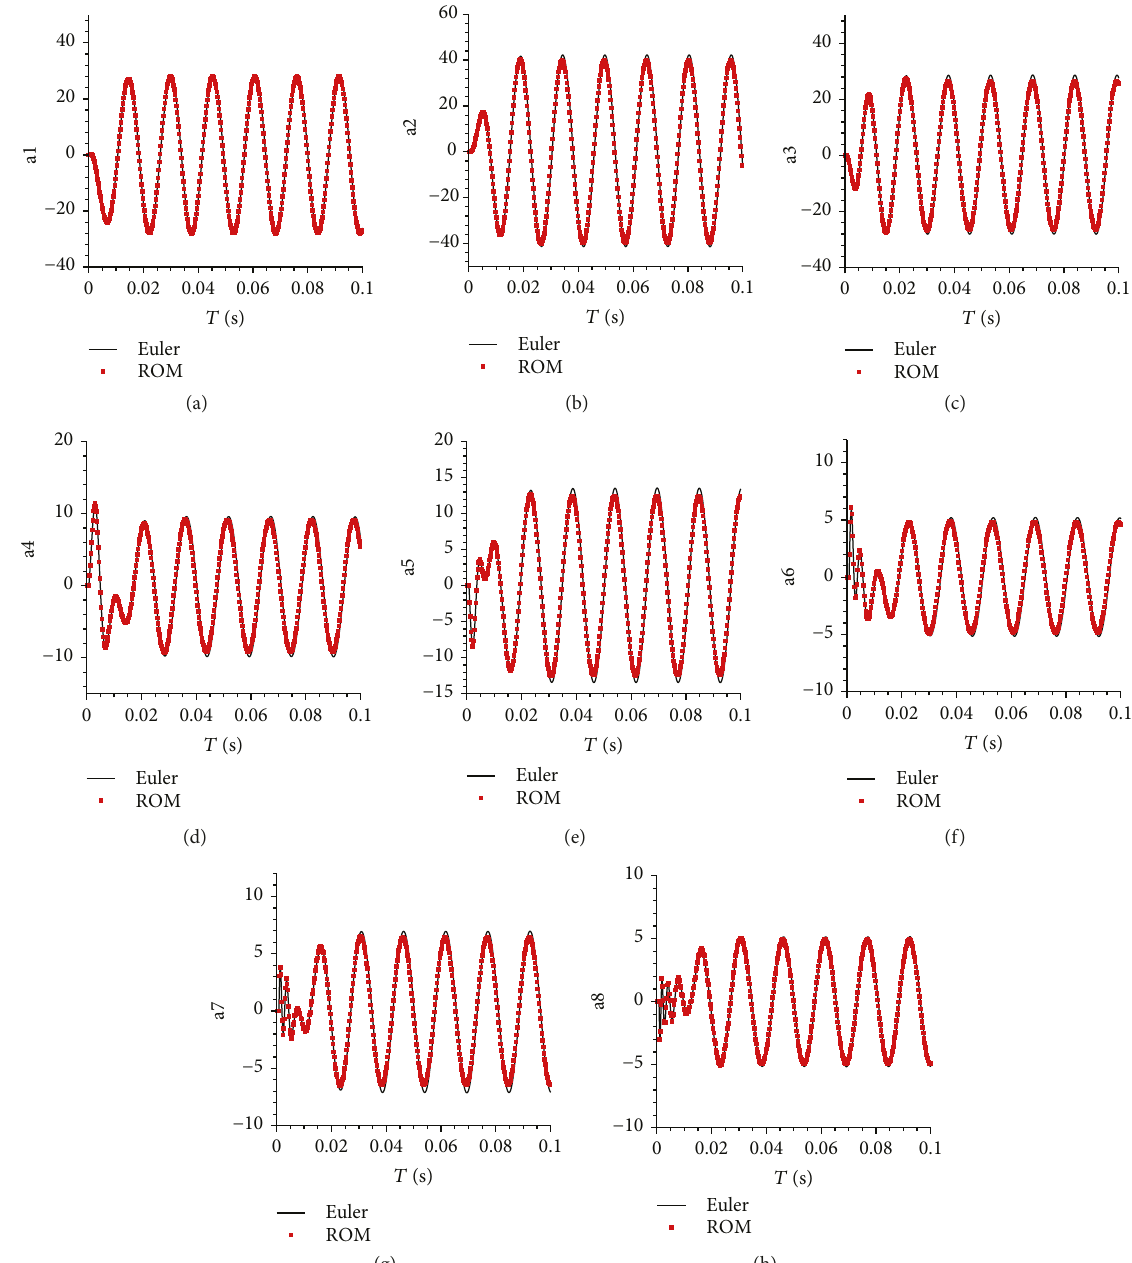
Figure 5: Comparison of modal coe ffi cients obtained from Euler and ROM solution to oscillation signal with f = 65